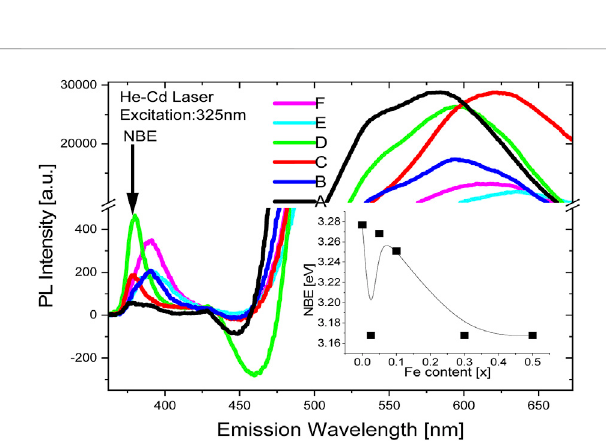
FIGURE 4 Global photoluminescence spectra recorded at 325 nm excitation wave-length for samples (A-F) containing different percentages of iron (0% to 50%) in ZnO. Abscissa-break in PL-intensity elucidates intense and broad luminescence in green-orange band. Vertical arrow and inset fi gure shows the positions near band edge luminescence from the assorted samples.